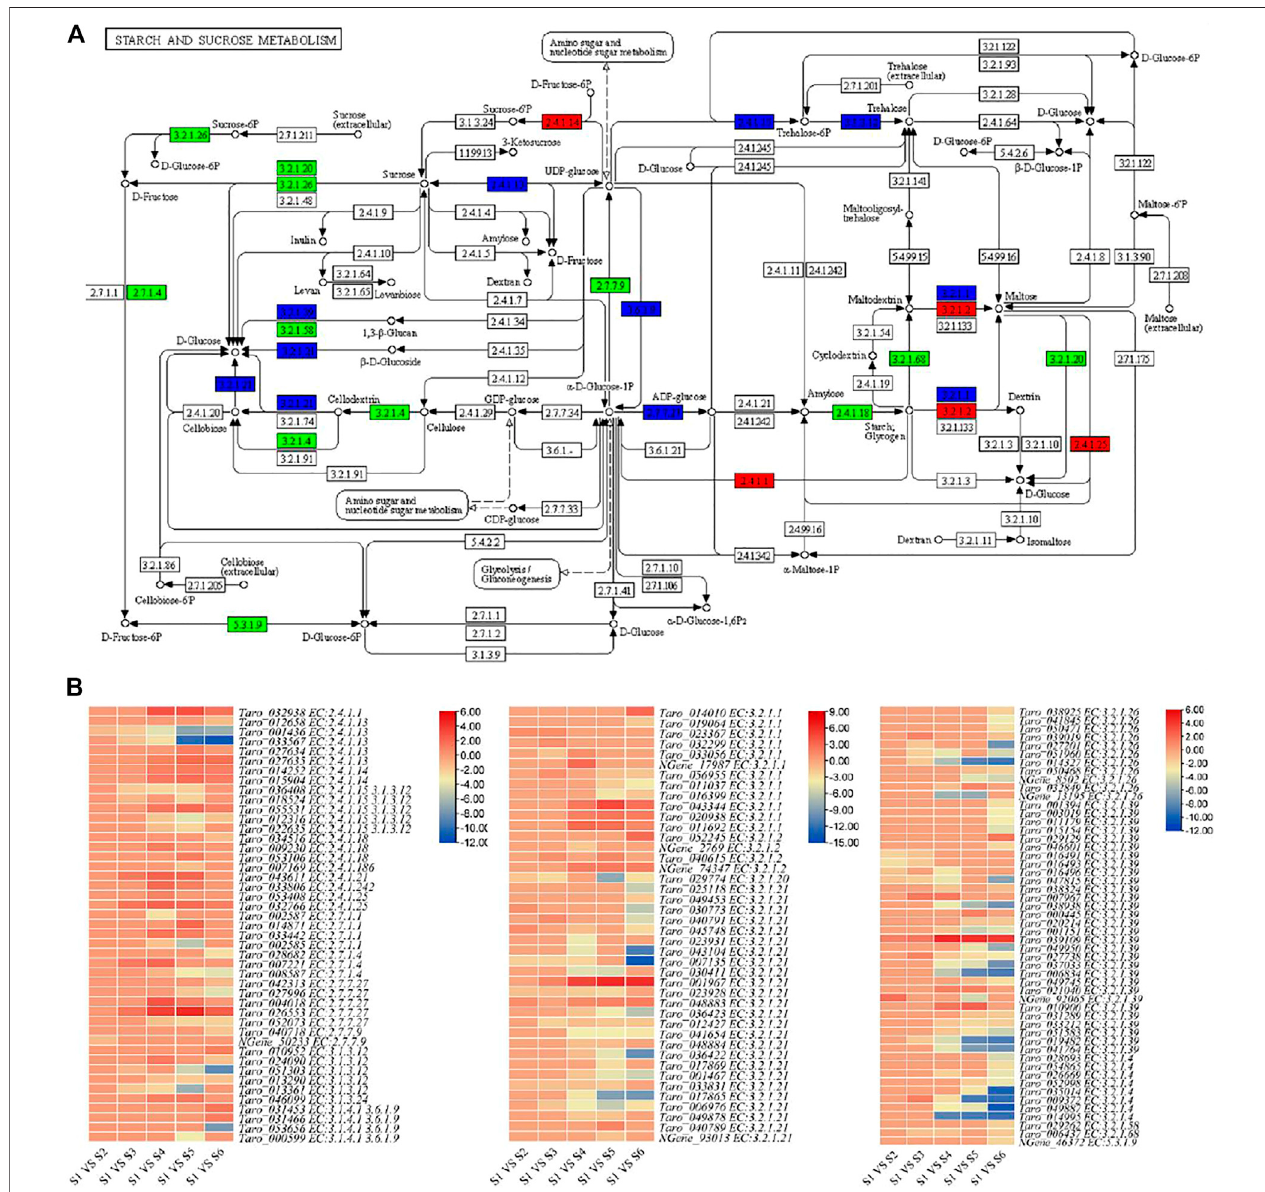
FIGURE4| Enrichmentofdifferentiallyexpressedgenesinstarchandsucrosemetabolismpathway. (A) Pathwaymapofstarchandsucrosemetabolismshowing identi fi edtranscriptsrelated toimportant enzymesofthispathway. Transcripts withelevated expression areshown inred. Downregulated transcripts are represented in greenand transcript withboth up- and downregulation arerepresented withblue color. (B) Heatmap representinglog2foldchangevalues ofthedifferentially expressed genes in starch and sucrose metabolism pathway.